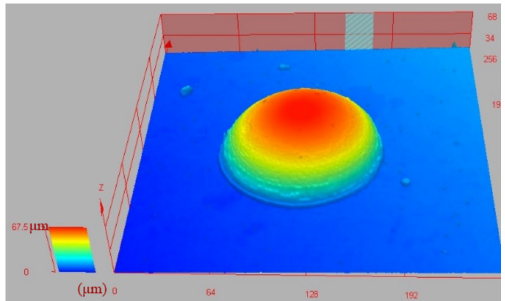
Figure 5. Single-particle, three-dimensional morphology of 316L deposit obtained by flame spraying with acetylene flow rate of 150 L/h and spray distance of 40